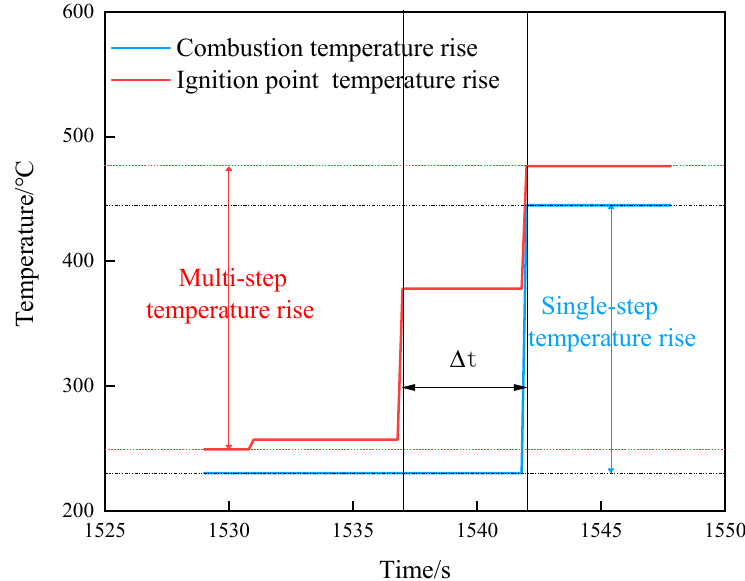
Figure 12. Temperature rise curve.